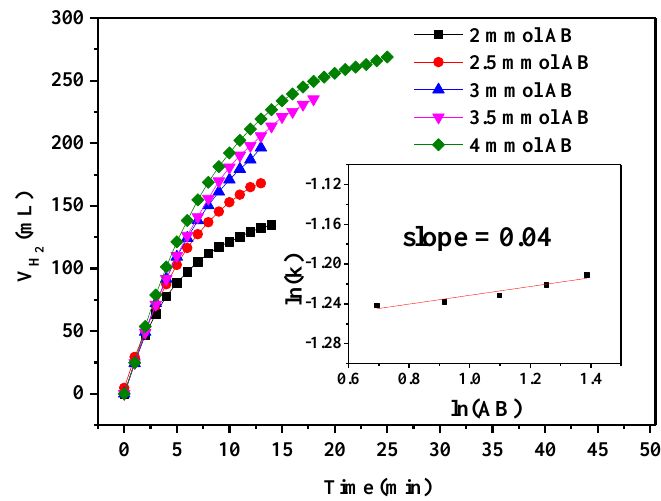
Figure 8. Hydrogen release at different concentrations of AB and the corresponding plot of ln(k) vs. ln(AB).